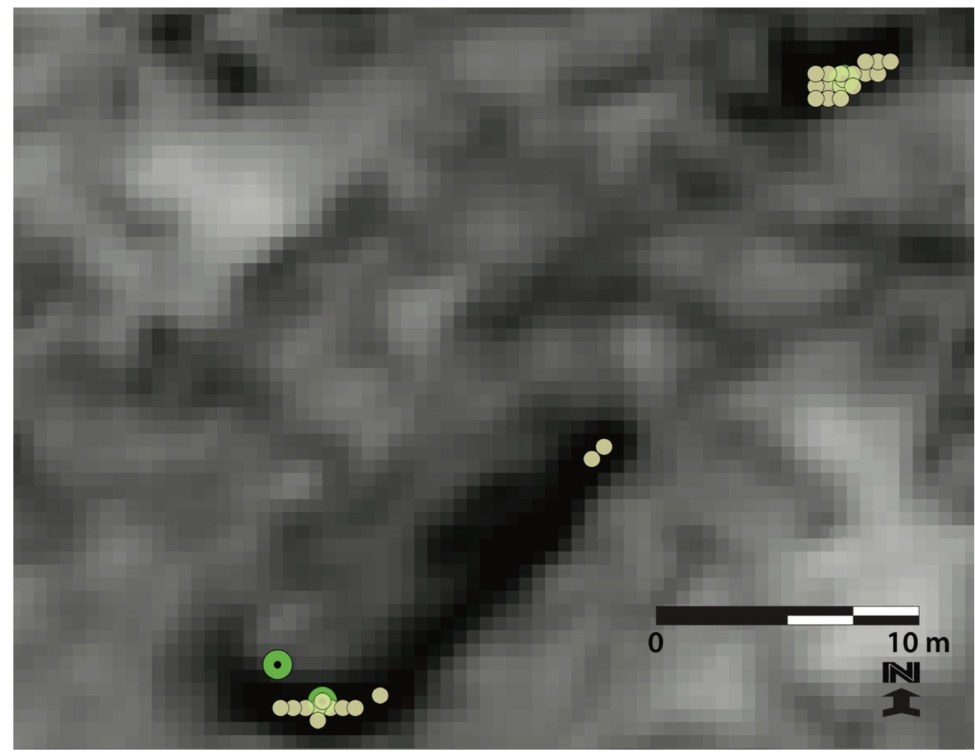
Figure 9. Example of pixel clustering (yellow circles) at confirmed cave locations (green circles) for midday thermal imagery, Pisgah Lava Field, Mojave Desert, CA,